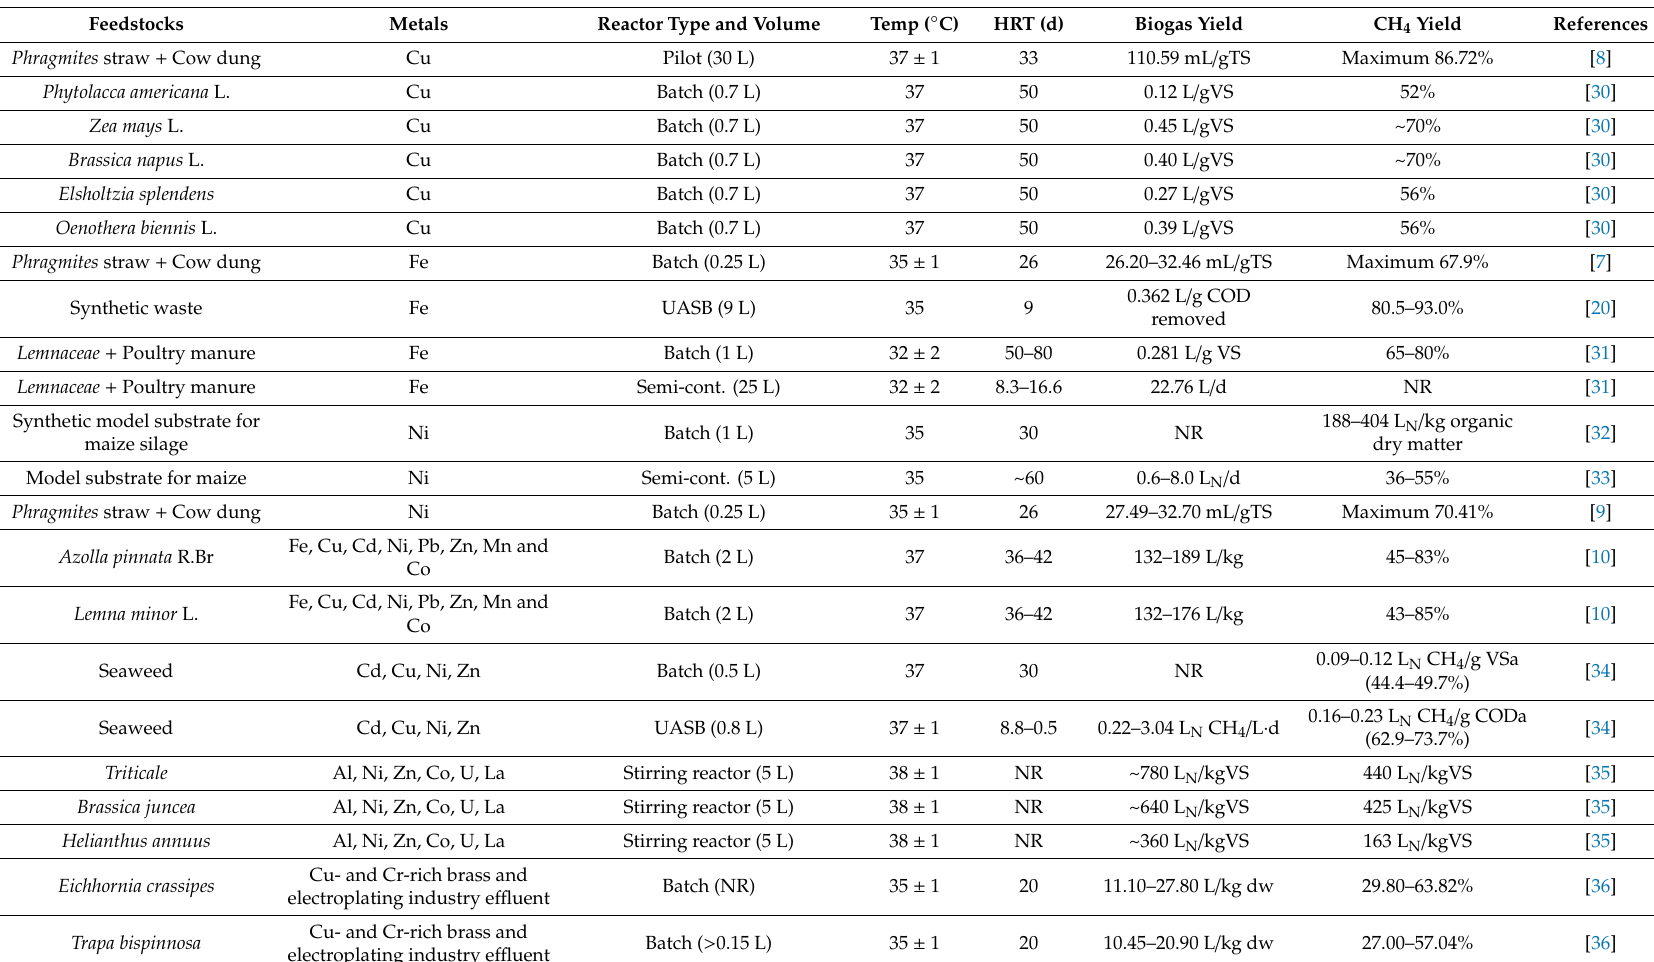
Table 1. Previous studies about the impact of Cu, Fe, Ni and Zn on anaerobic